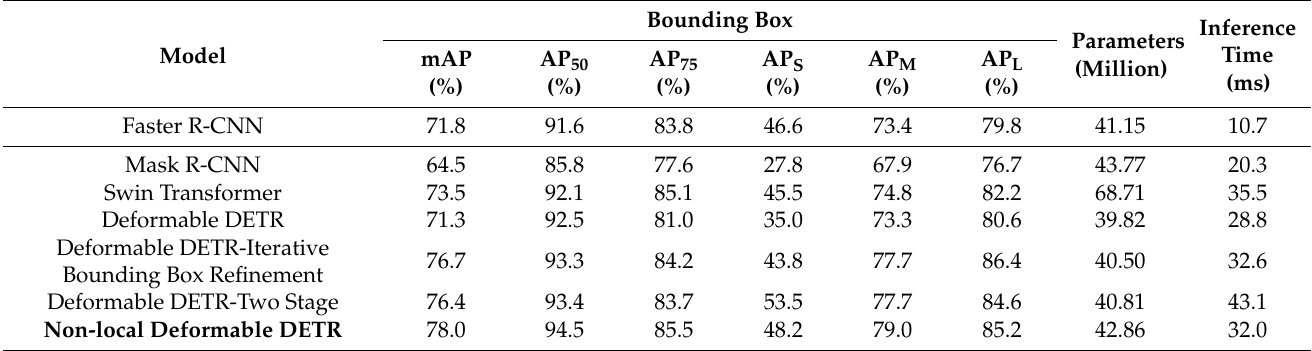
Table 1. Performance comparison between different models.